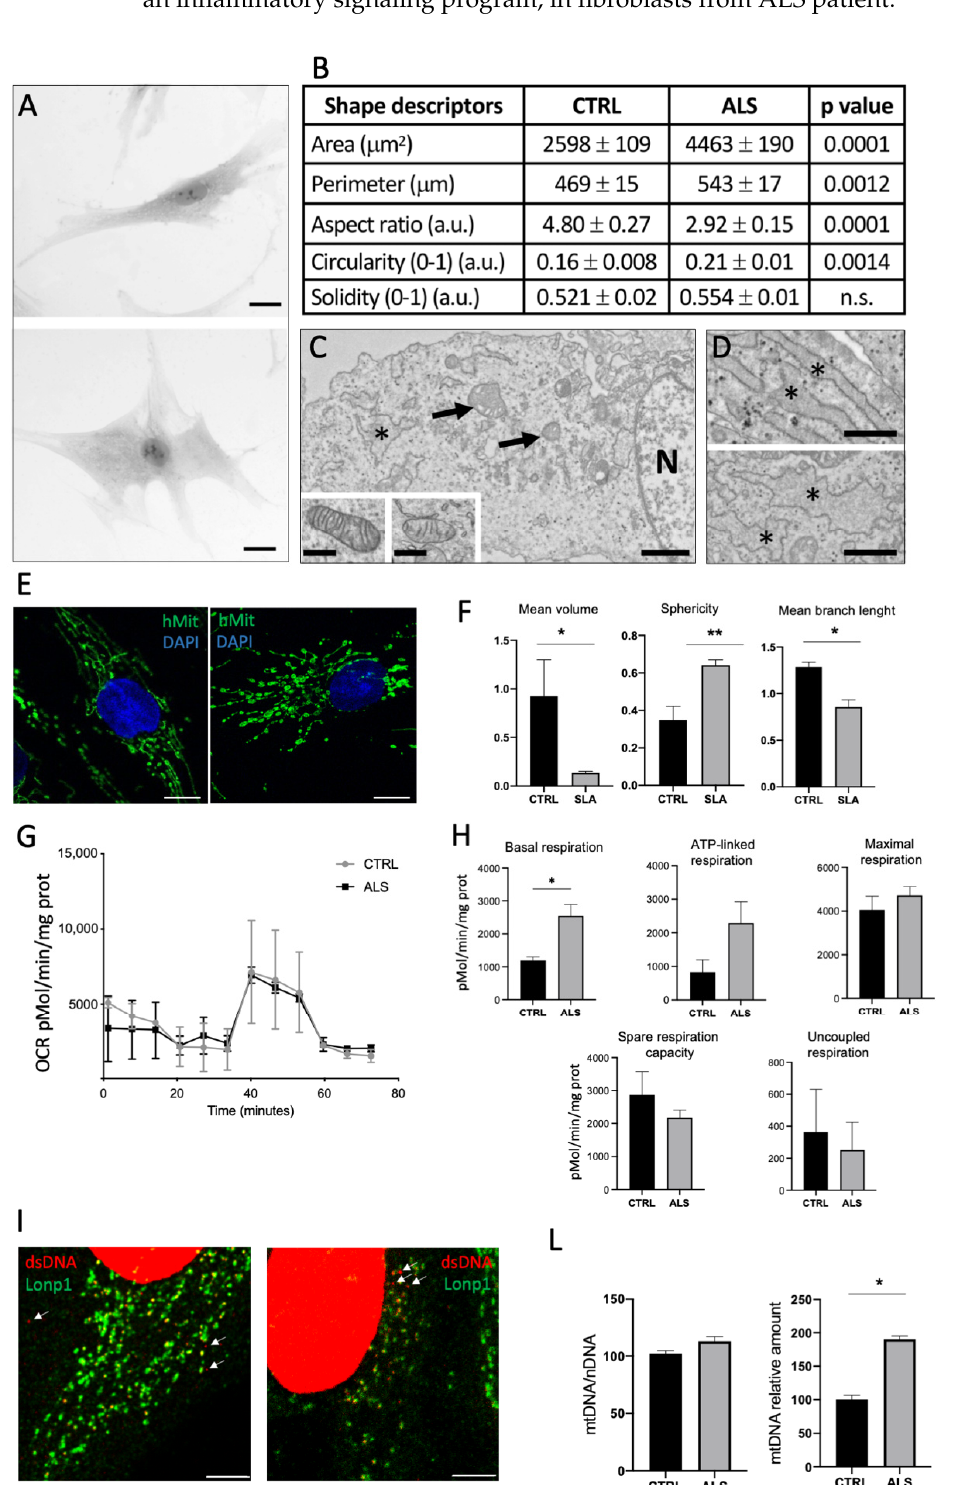
Figure 3. ( A ) Representative light microscopy images of fixed primary skin fibroblasts isolated from CTRL (up) and ALS (down) and stained with toluidine blue. Scale bar = 20 μ m. ( B ) Quantification of area, perimeter, aspect ratio, circularity, and solidity are reported as mean ± SE. For each cell line 120 cells were analysed. a.u.= arbitrary unit. ( C ) Representative electron micrographs of ALS fibroblasts. N= nucleus; * = endoplasmic reticulum. Mitochondria are indicated by arrows. Scale bar = 1 μ m. Inserts show a mitochondrion from CTRL (left) and from ALS fibroblast (right). Insert bar =